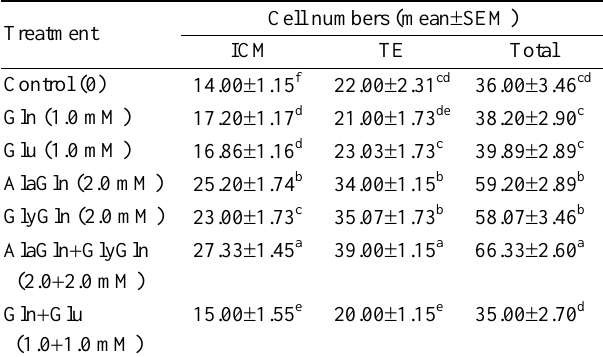
Values shown were obtained based on 30 embryos from three replicates. Within the same column, values with different superscript letters (a-f) are significantly different